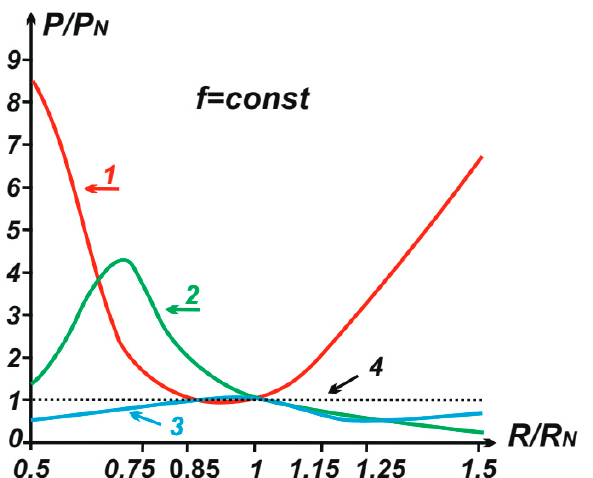
Figure 6. Comparison of the output characteristics P/PN = f(R/RN) of the full-bridge-current-fed inverter (1), half-bridge RI (2), RI with ED and reverse diodes (3) and RI with ED without reverse diodes (4).